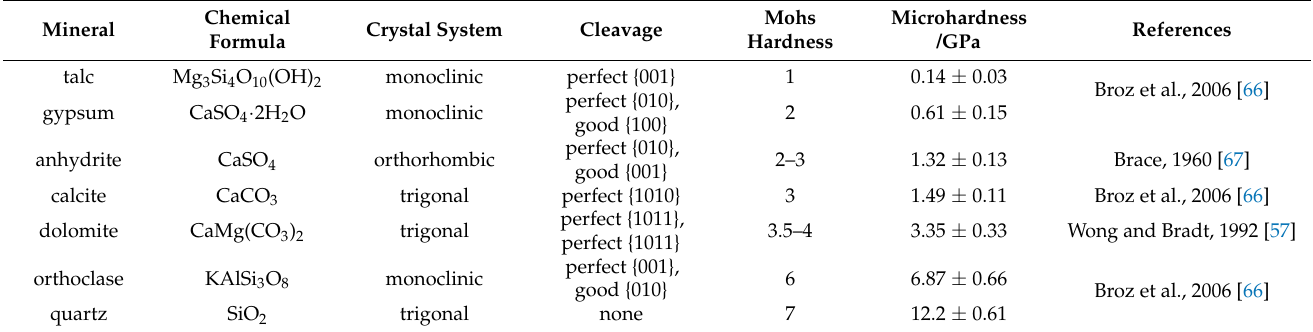
Table 5. Mineralogical information of common rock-forming